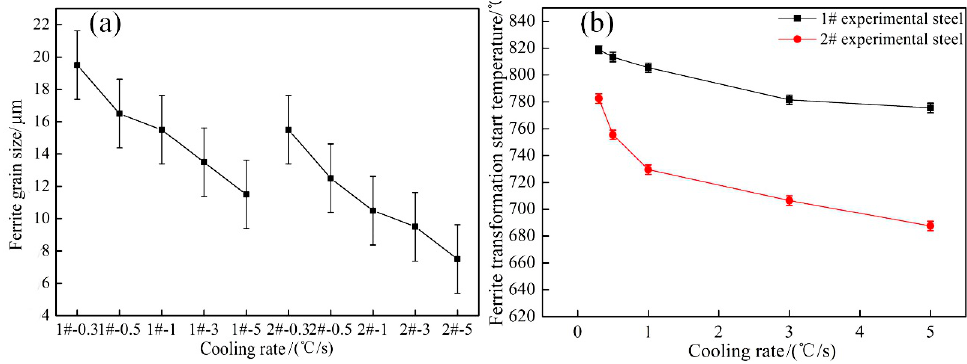
Figure 10. Ferrite grain size ( a ) and ferrite transformation start temperature ( b ) of steels 1# and 2# at different cooling rates.